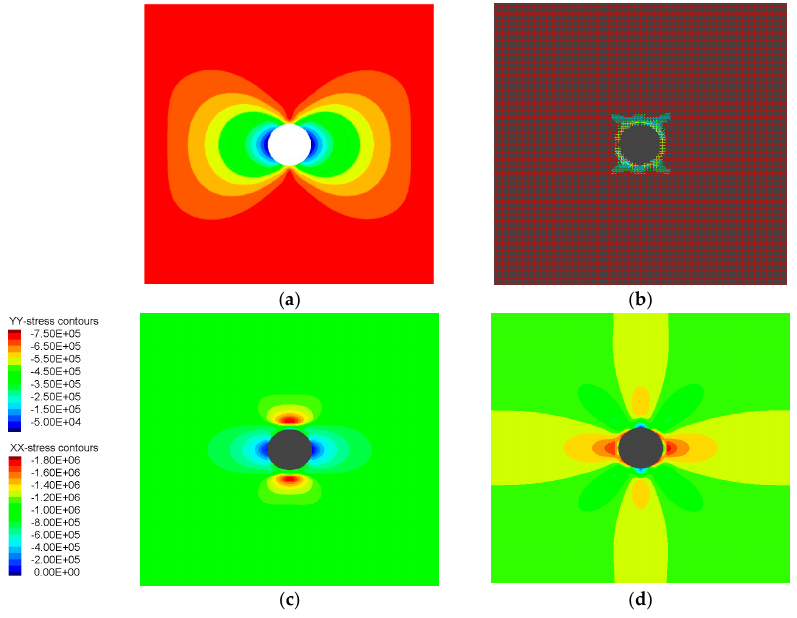
Figure 25. Simulation results for tunnel model with two joint sets (45 ◦ and − 45 ◦ ) and κ = 0.5: ( a ) displacement contours [m], ( b ) plasticity state, ( c ) contour plot of horizontal stresses [Pa] and ( d ) contour plot of vertical stresses